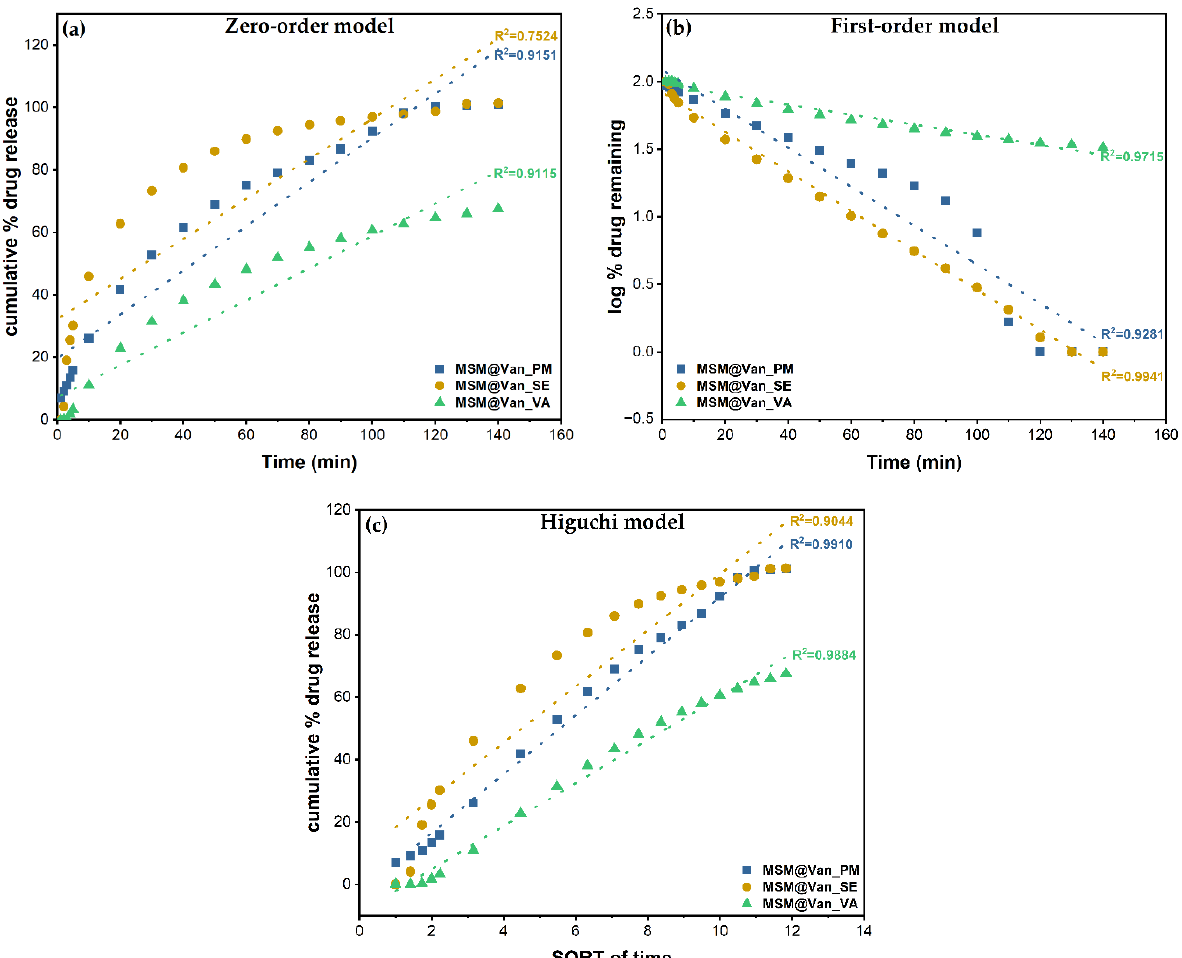
Figure 8. Zero order ( a ), First order ( b ), and Higuchi ( c ) models applied to the three different loading procedures. Table 5. Correlation coefficients and release constants derived from regression analysis.